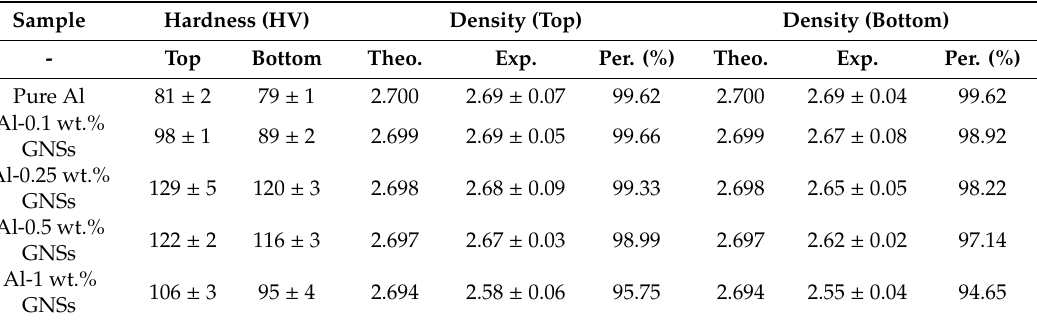
Table 2. Theoretical / experimental densities and the microhardness (Vickers) of pure Al and its nanocomposites for the top and bottom of each sample. The measurement was performed in the center of the billets’ cross-section. Sample Hardness (HV) Density (Top) Density